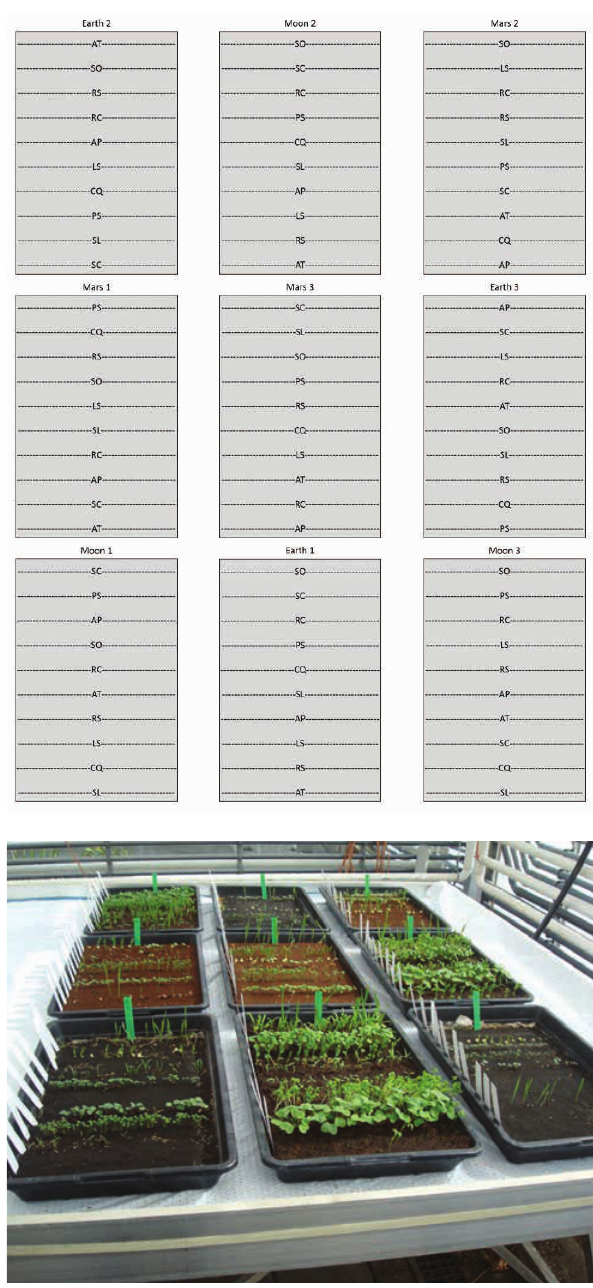
Figure 1: Top panel: experimental design, with SO: Spinach ( Spinacia oleracea ), PS: Peas ( Pisum sativum ), SC: Rye ( Secale cereale ), RC: Rocket or Arugula ( Rucola coltivata ), SL: Cherry tomato ( Solanum lycopersicum ), AP: Leek ( Allium porrum ), LS: Cress ( Lepi- dium sativum ), RS: Radish ( Rhaphanus satives ), AT: Carlic chives